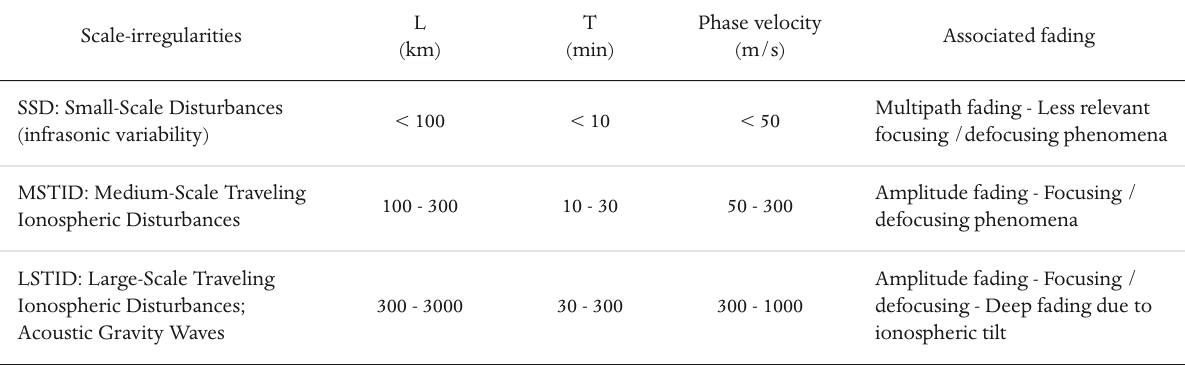
Table 2. TID classes according to their horizontal scales derived from Crowley and Rodrigues